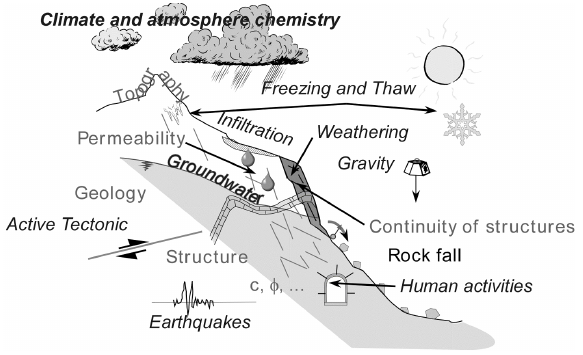
Fig. 5. EF and IP for rockfall (modified from Jaboyedoff and Labi- ouse, 2003; Jaboyedoff and Derron, 2005).